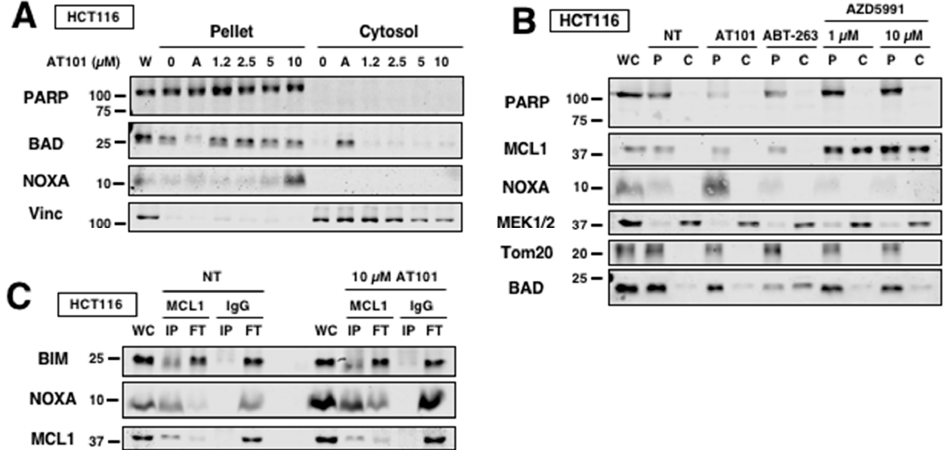
Figure 6. AT101 primes cells for sensitization through NOXA induction. ( A ) HCT116 cells were incubated with either 10 µ M ABT-263 (“A”) or AT101 for 6 h and then permeabilized with digitonin and separated into pellet and cytosolic fractions. Translocation of BAD was measured by Western blotting. PARP and vinculin were used as controls for pellet and cytosol, respectively. ( B ) HCT116 cells were incubated with either ABT-263 (10 µ M), AT101 (10 µ M) or AZD5991 (1 or 10 µ M) for 6 h and then permeabilized with digitonin and separated into pellet and cytosolic fractions. PARP and MEK1 / 2 were used as controls for pellet and cytosol, respectively. Tom20 was used as a mitochondrial marker. ( C ) HCT116 cells were incubated with 10 µ M AT101 for 6 h and then subjected to MCL1 immunoprecipitation. Lysates were separated into immunoprecipitate (IP) and flow-through (FT) with IgG used as a negative control. BIM, NOXA and MCL1 expression were measured by Western